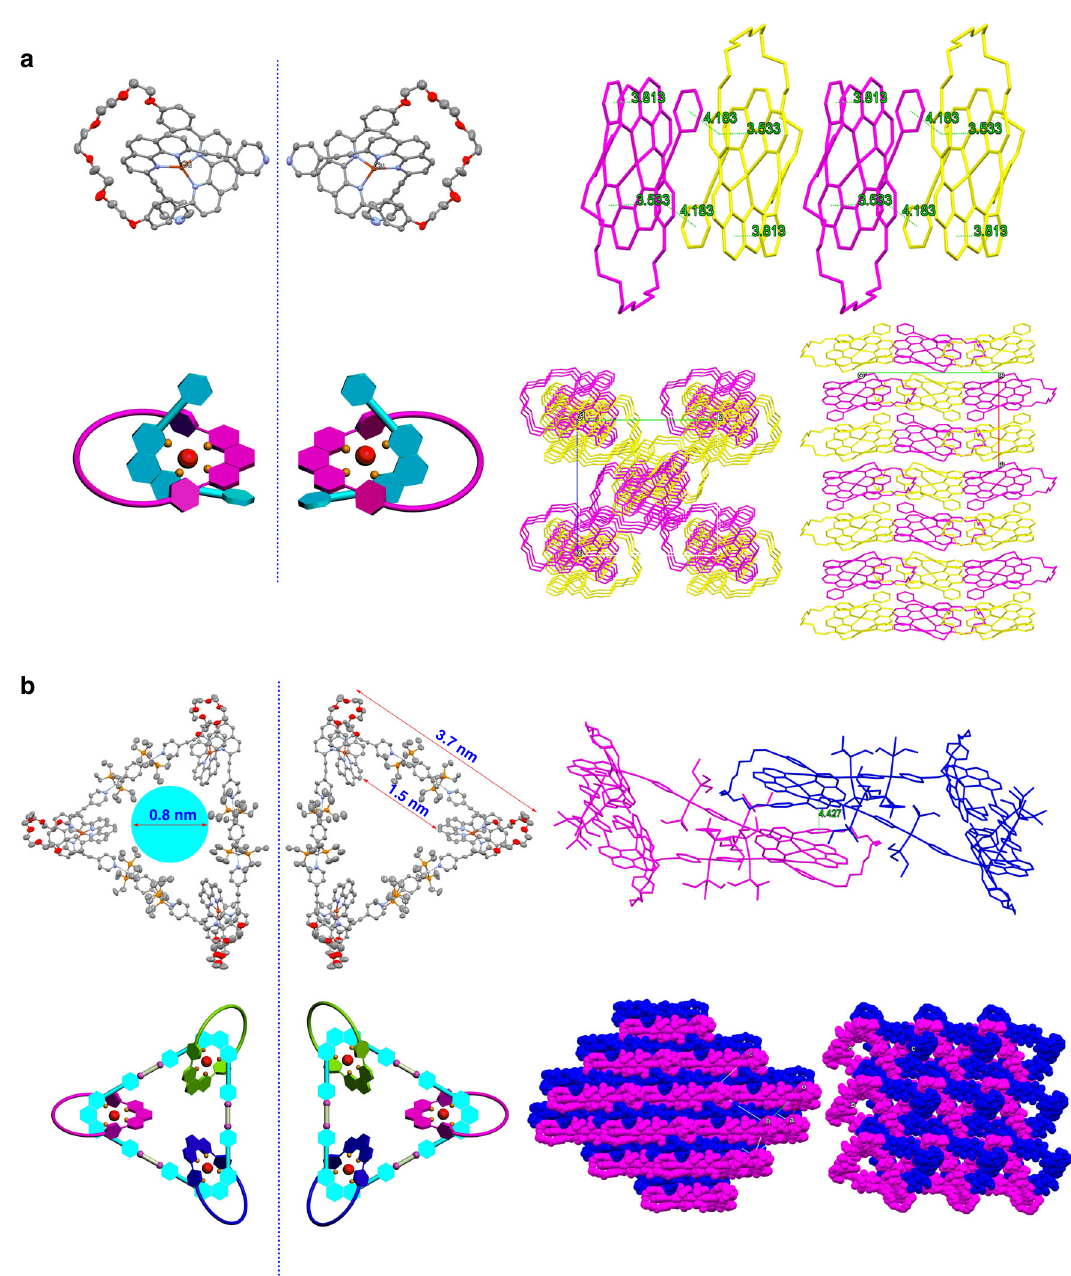
Fig. 4 Single-crystal X-ray structure analysis. ORTEP drawings and 3D packing structures (both top-view and side-view) of a D1 and b 1 . The two enantiomers of D1 and 1 are also presented in cartoon format. Hydrogen atoms and PF 6 − anions are omitted for